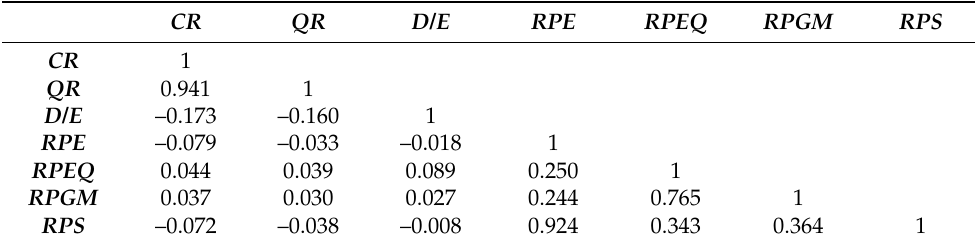
Table 7. Correlation matrix for gas companies.